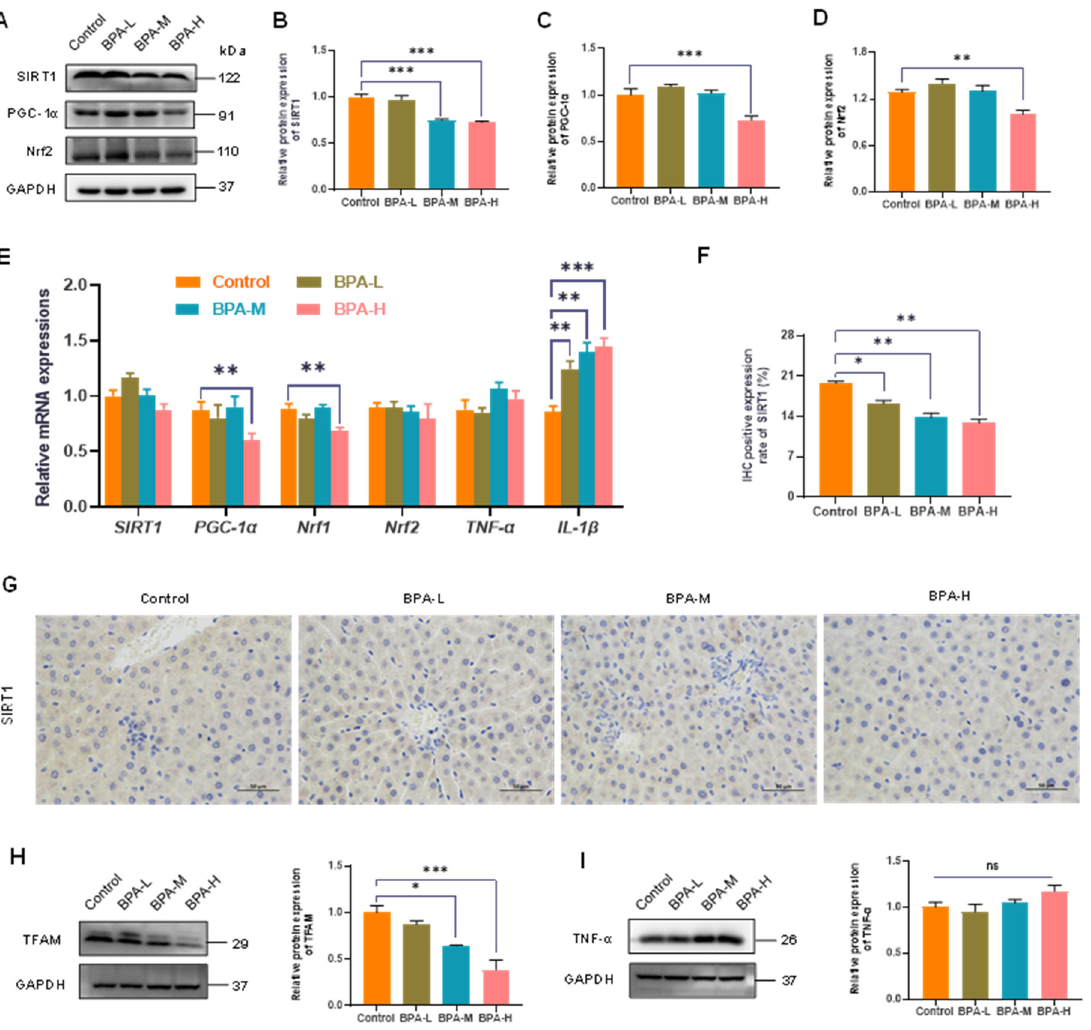
Figure 3. Effects of BPA on the liver SIRT1/PGC-1 α pathway. ( A ) The relative protein levels of PGC-1 α , Nrf2, and SIRT1. ( B – D ) Values of quantitative analysis ( n = 4). ( E ) Relative mRNA levels